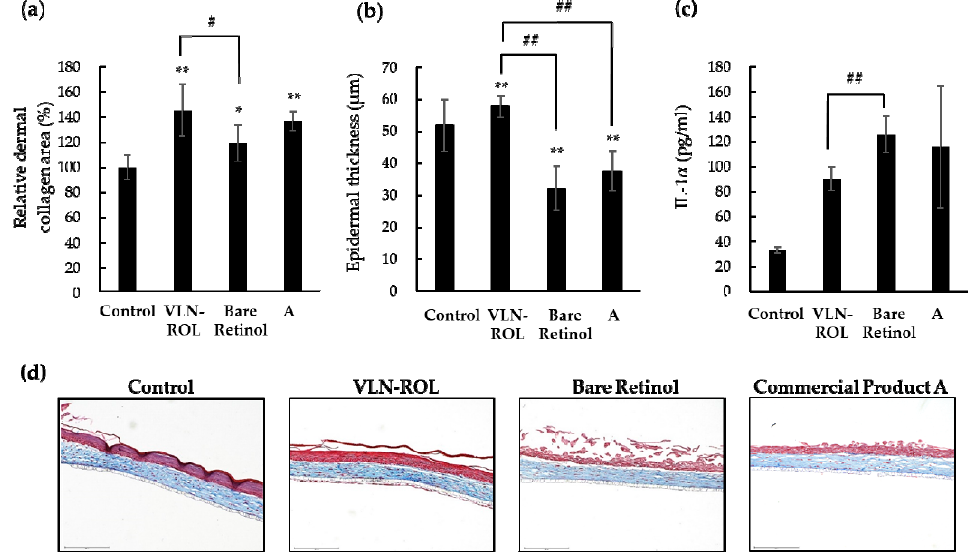
Figure 5. Comparison of effects between VLN-ROL, retinol and commercial product A. Three different formulations containing VLN-ROL and bare retinol, and commercial product A, were, respectively, applied on the top of the 3D human skin model. Each formulation contained 0.1% VNL-ROL or bare retinol. ( a ) Relative dermal collagen area and ( b ) epidermal thickness were both measured with the Celleste™ image analysis software. ( c ) IL-1 α secreted by the 3D human skin model was measured. ( d ) Sectioned 3D human skin images after Masson’s trichrome staining (* p < 0.05, ** p < 0.01, # p < 0.05, and ## p < 0.01, indicate significantly difference between groups).